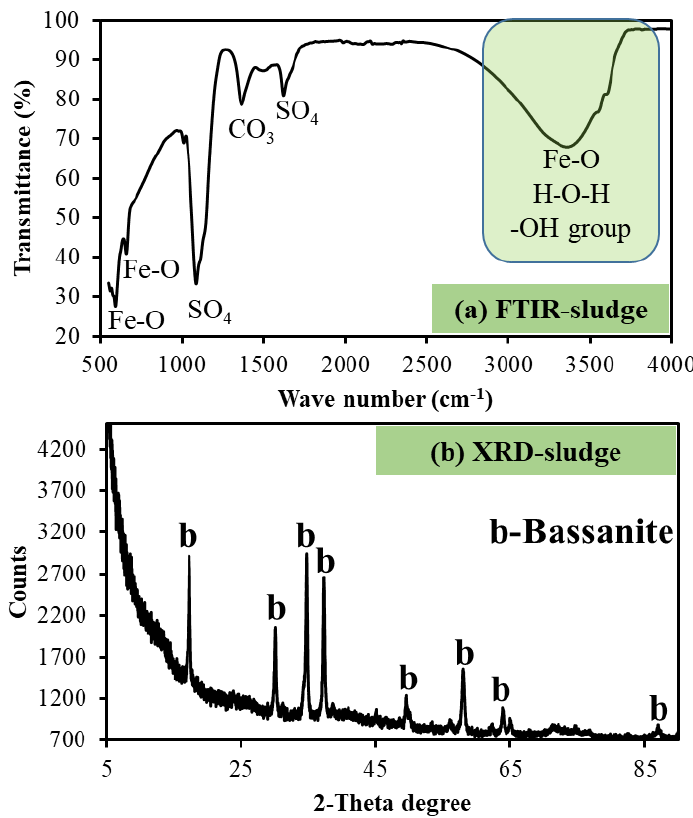
Figure 3. The ( a ) functional groups and ( b ) mineralogical characteristics of the product sludge, where lower- case “b” in the diffractogram stand for “Bassanite” . lower-case “b” in the diffractogram stand for